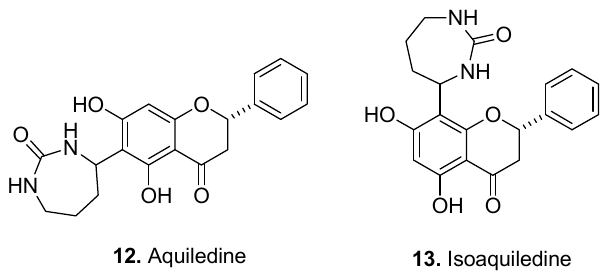
Figure 5. Aquiledine ( 12 ) and isoaquiledine ( 13 ).